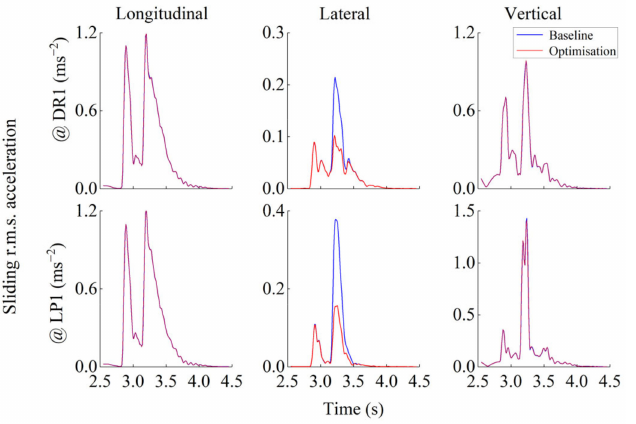
Figure 9. Comparison of running r.m.s. accelerations at seat rails between the baseline and optimized models.